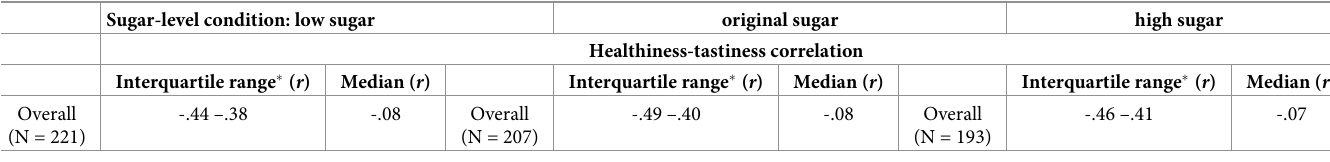
Table 5. Range and median values for correlations between healthiness and tastiness ratings across sugar-level conditions. Sugar-level condition: low